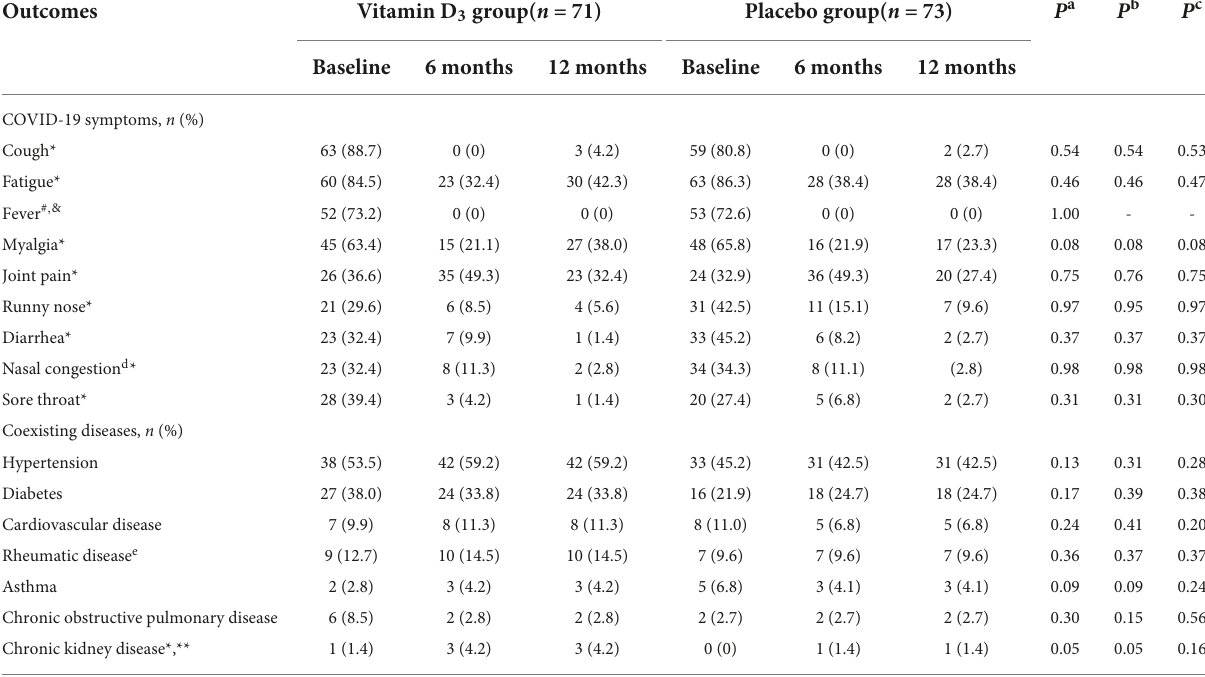
TABLE 2 Persistence of symptoms and coexisting diseases from baseline to 1 year after hospital discharge for COVID-19. Outcomes